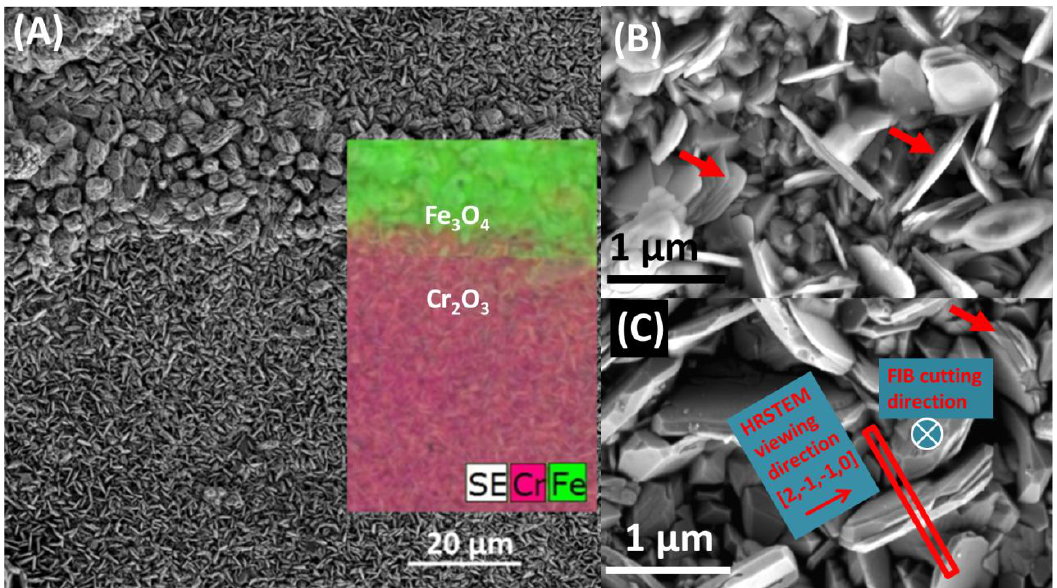
Figure 3. Morphology of oxide scale, grown on Sanicro 25 after oxidation at 700 °C (SEM-SE): ( A ) an overview of the surface after 500 h of oxidation. In the inset, the SE image was overlaid on the EDS results to enhance contrast of the elemental map, ( B ) plates after 500 h of oxidation at higher magnification, ( C ) plates after 10,000 h of oxidation at higher magnification. Overlays showing the direction of focus ion beam (FIB) lamella cut.